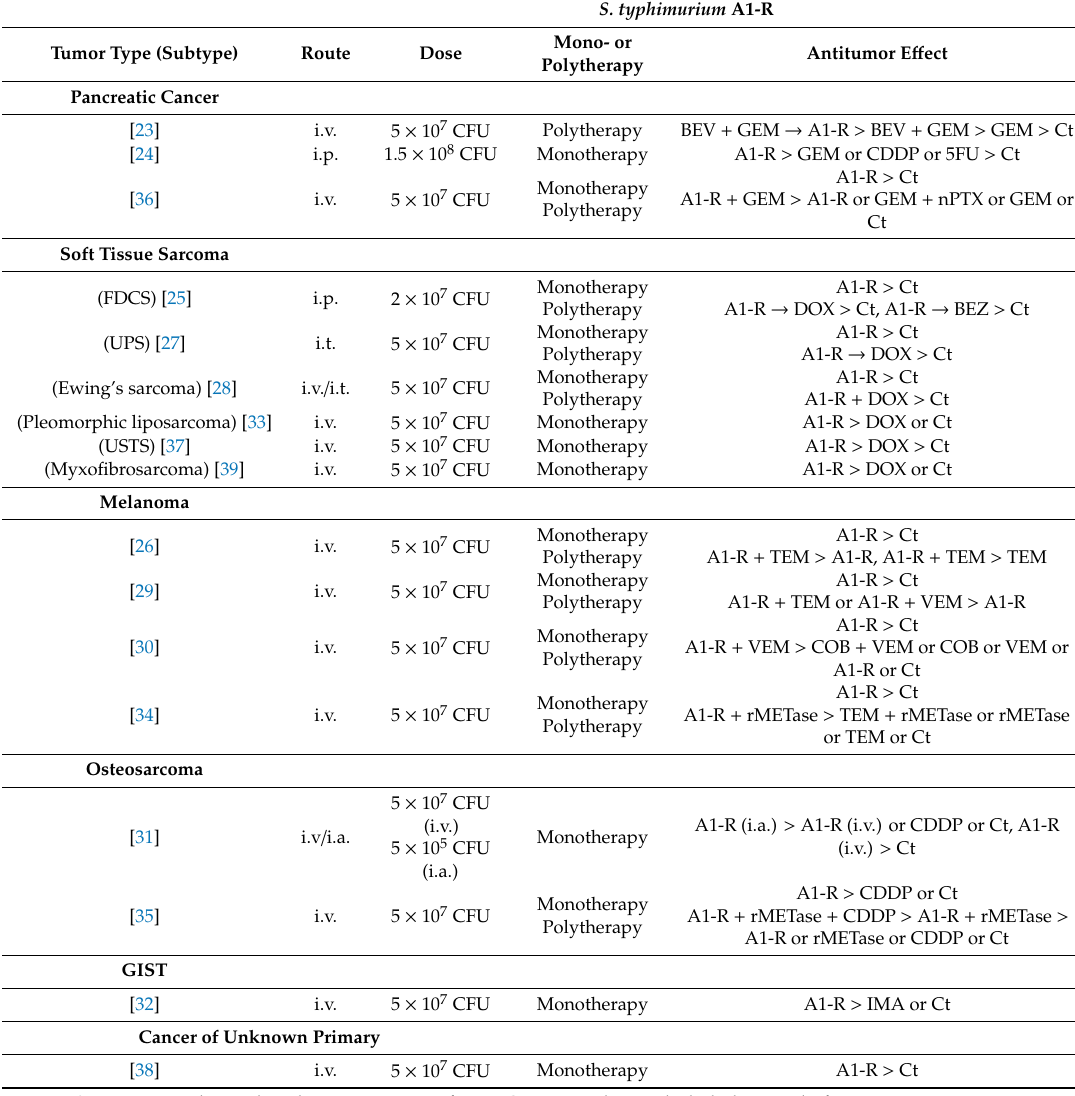
Table 2. E ffi cacy of S. typhimurium A1-R was administered on PDOX